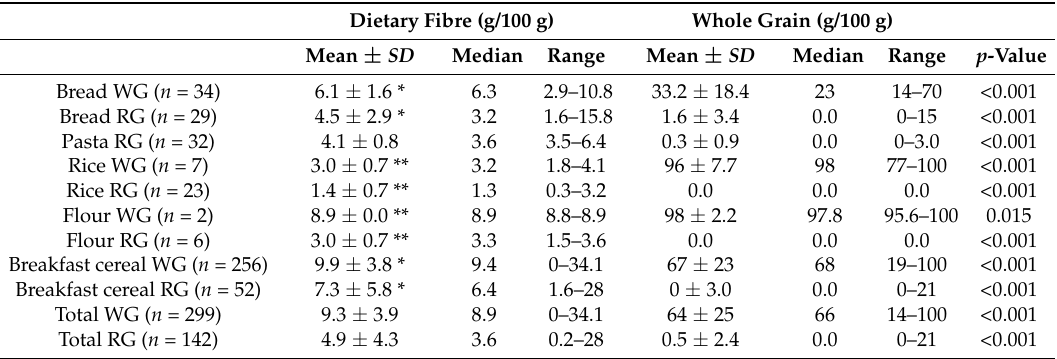
Table 4. Comparison of dietary fibre and whole grain (g/100 g) within whole grain (WG) and refined grain (RG) subcategories and dietary fibre between WG and RG